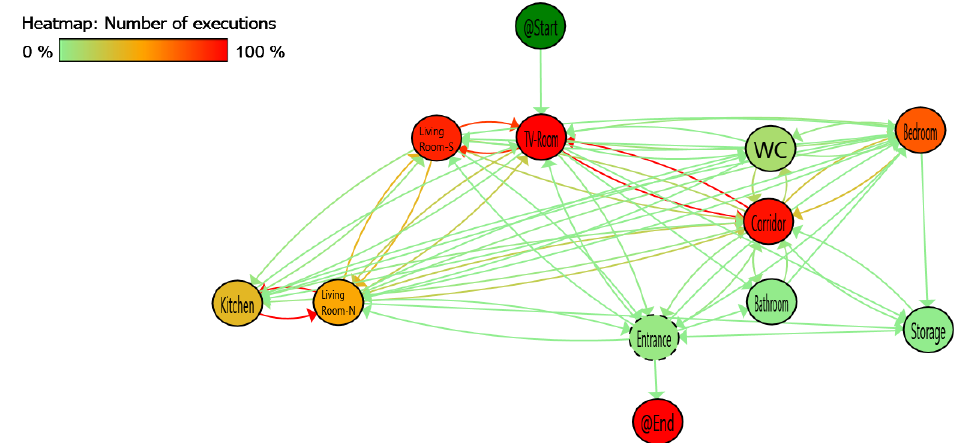
Figure 7. Deployment phase process mining data analysis: A colour heat map is applied based on the number of executions, red shows the most executed and green less executed.